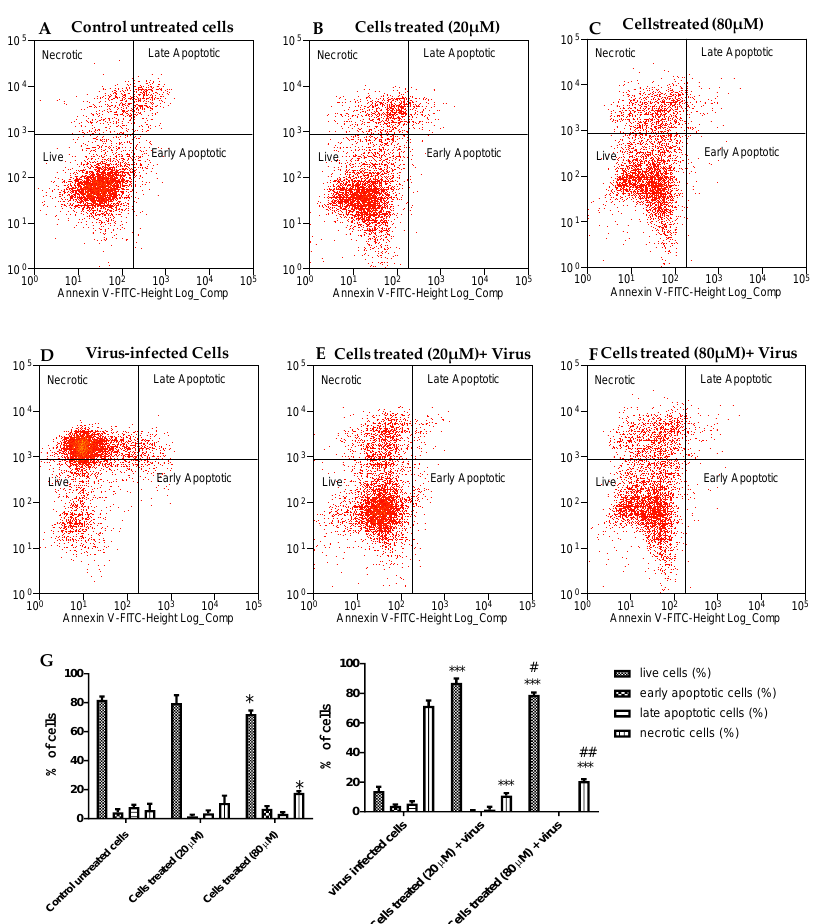
Figure 2. The inhibitory effect of compound 2b on EV-A71-induced apoptosis. The percentage of live, apoptotic, and necrotic cells were measured by flow cytometry using the PI-annexin V assay. Dot plots show cell death in Vero-76 cells: control ( A ), treated cells with 20 µM ( B ), treated cells with 80 µM ( C ), infected cells ( D ), infected treated cells (20 µM) ( E ), and infected treated cells (80 µM) ( F ). Percentage of live, apoptotic, and necrotic cells ( G ). Statistically significant differences are expressed as follows: * = p < 0.05 vs. untreated cells; *** = p < 0.001 vs. untreated cells; # = p < 0.05 vs. cells treated (20 µM) + virus; ## = p < 0.01 vs. cells treated (20 µM) + virus.